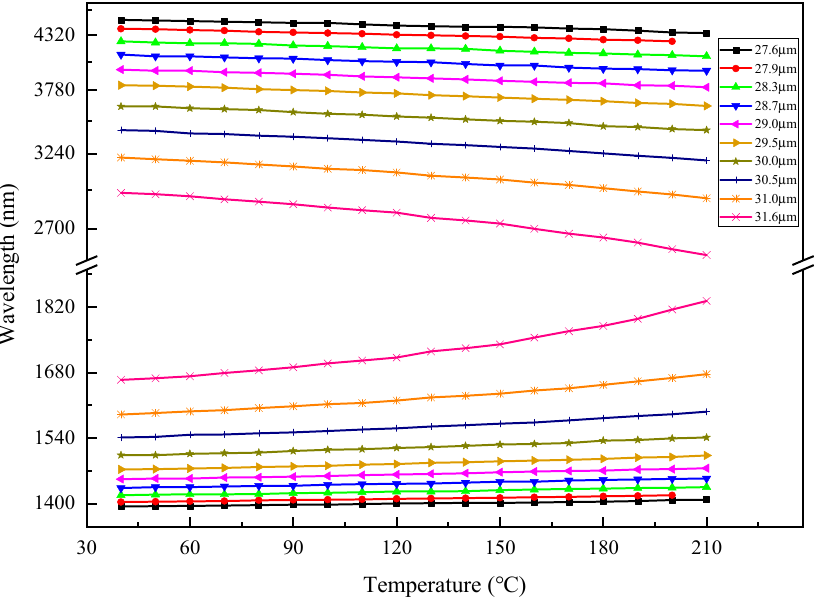
Figure 2. Wavelength tuning of the idler beam and signal beam.